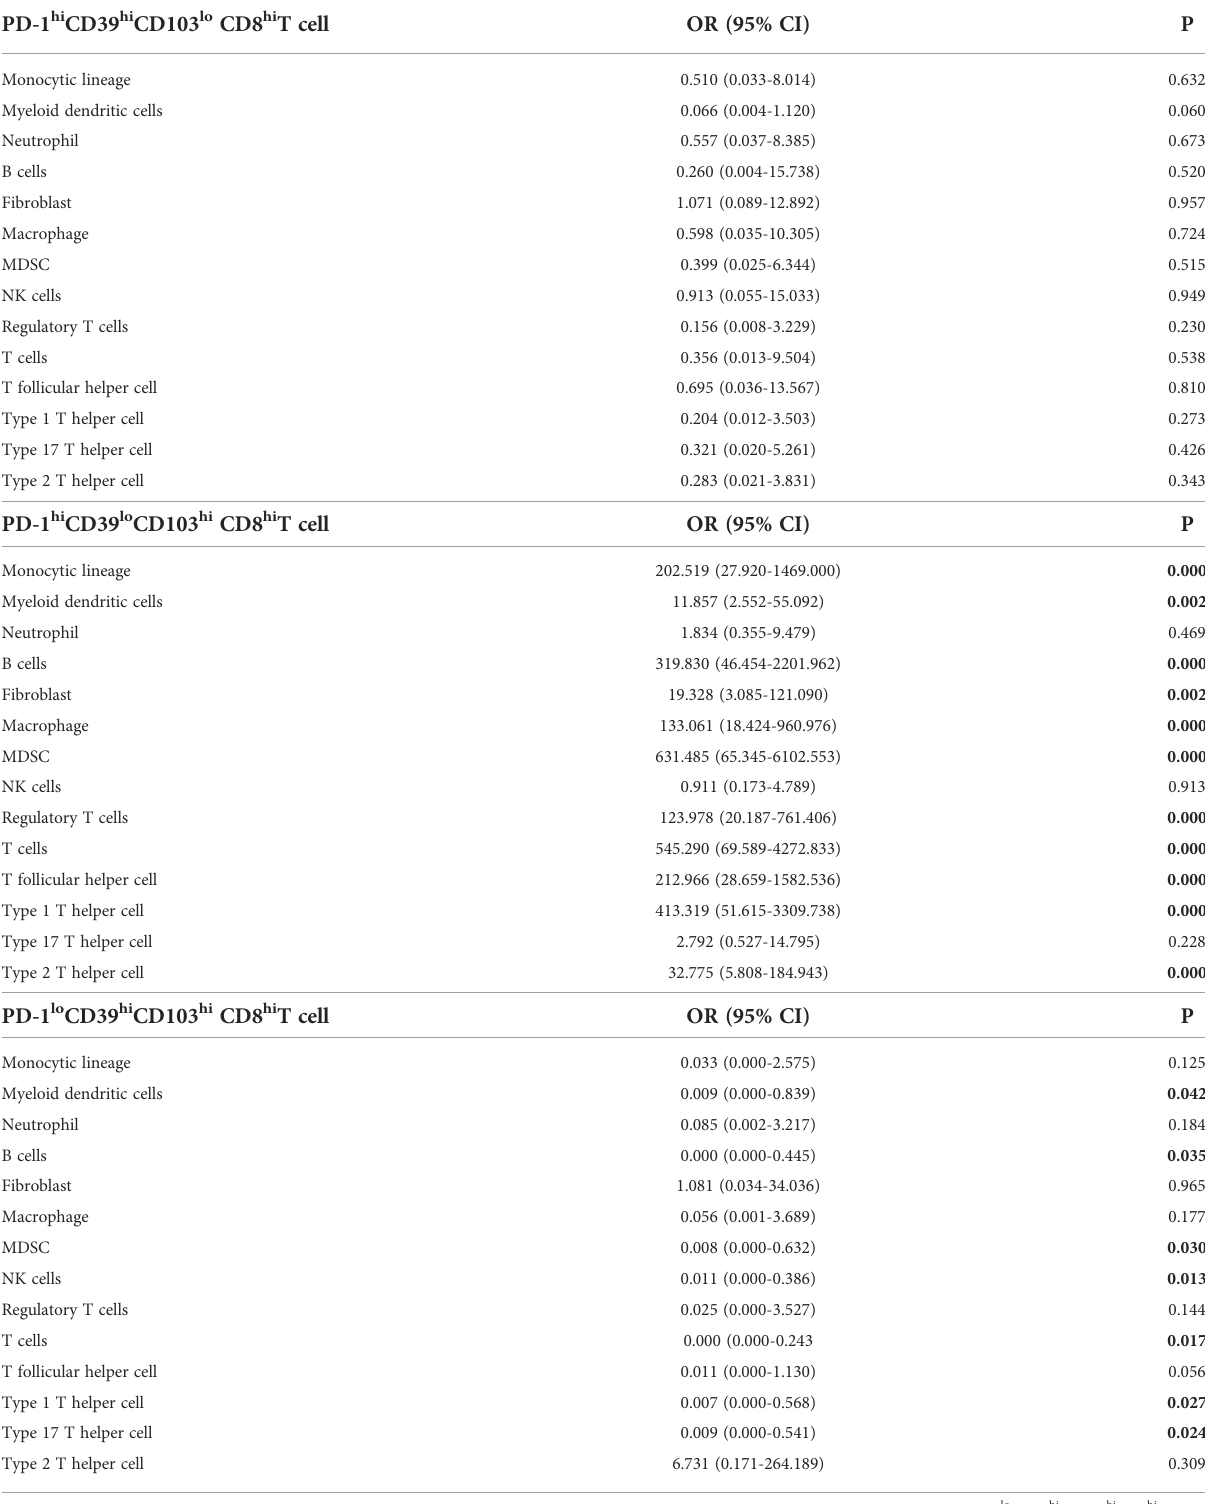
TABLE 4 Multinomial logistic regression analysis of immune cells associated with PD-1 hi CD39 hi CD103 lo CD8 hi T, PD-1 hi CD39 lo CD103 hi CD8 hi T,